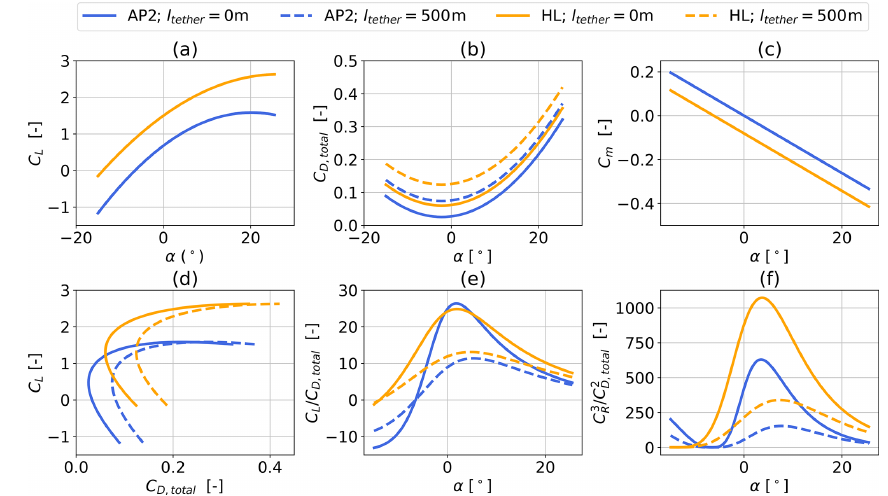
Figure 4. The dashed lines in (b) show C D , total (aircraft + 500m tether), while the solid lines show C D , wing (only aircraft). Aerodynamic lift C L (a) and pitch moment C m coefficients (c) , each with (dashed line) and without tether drag (solid line) as a function of angle of attack for AP2 (blue) (Licitra, 2018; Malz et al., 2019) and high-lift (HL) (orange) configuration. (d) displays lift as a function of total drag, /c 2 (e) lift-to-drag ratio over angle of attack and (f) c 3 over angle of attack according to Loyd (1980). HL coefficients are derived by R D , total modifying the AP2 reference model as if arbitrary high-lift devices were